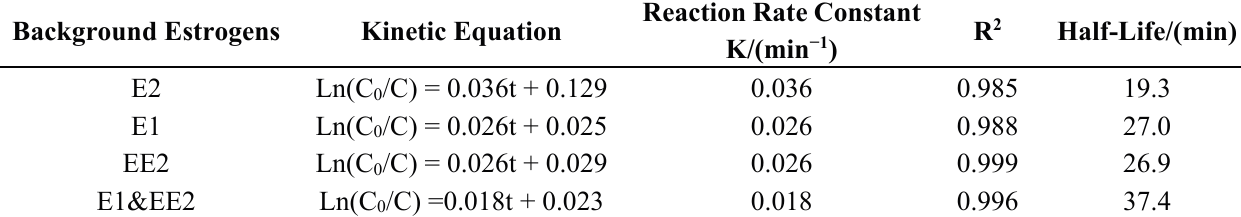
Figure 3. Degradation and reaction kinetics of E2 under single and combined estrogen pollution. Table 2. Kinetic parameters of degradation of E2 under single and combined estrogen